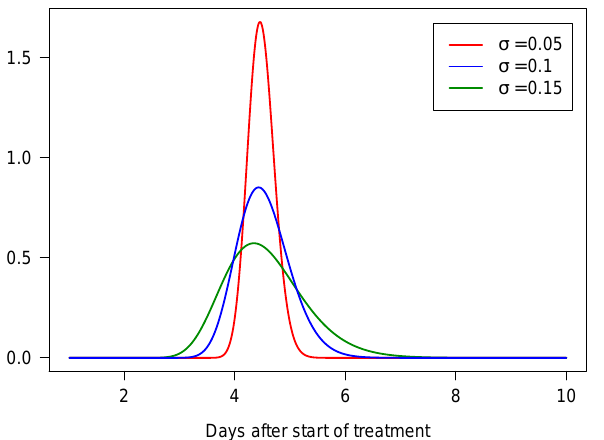
Figure 6. Approximations of the density function of the time required to quadruple the initial tumor volume from simulated sample paths of the lognormal diffusion process with m = 0.4 and σ = 0.05, 0.1,